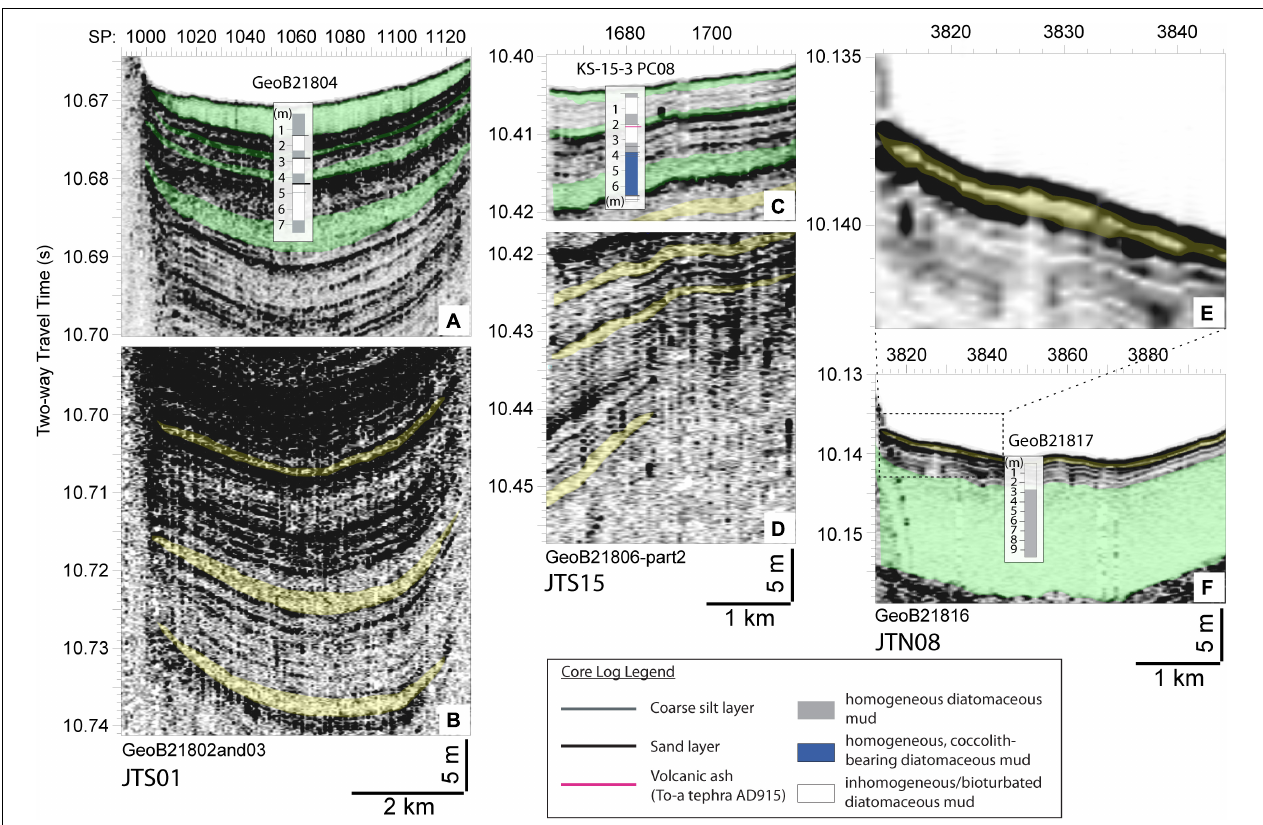
FIGURE 4 | Close-up examples of acoustically transparent bodies and SBP-to-core correlation. Note that the deeper intervals of SBP images (B,D) are gained as compared with the shallower intervals (A,C) . The deeper interval of SBP image (F) is presented at a reduced vertical exaggeration as compared with the shallower interval (E)